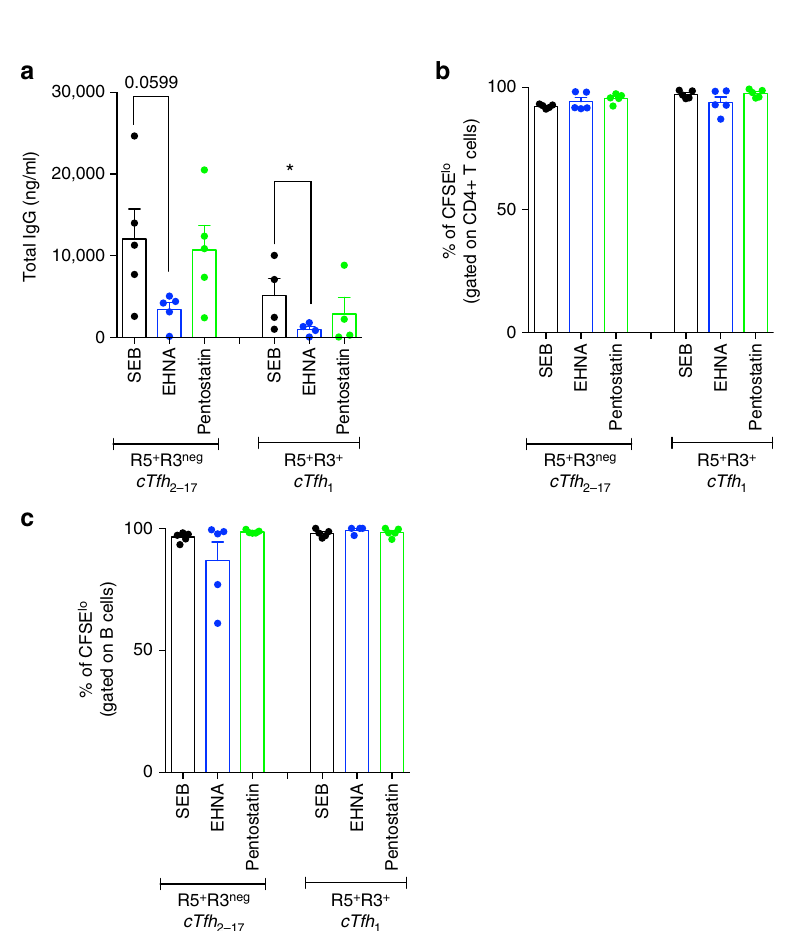
Fig. 3 Blocking of ADA with EHNA does not impair T- and B-cell proliferation abilities. a Production of IgG in the supernatants of 7-day co-cultures of cTfh and non-cTfh co-in the presence of ADA-inhibitors EHNA or Pentostatin ( n = 5, in two-independent experiments). (ANOVA, paired, two-tailed non- parametric t -test; * p < 0.05; Mean ± SEM). b Percentage of CFSE lo T cells after 7-day co-cultures of cTfh subsets with memory B cells in the presence of ADA-inhibitors EHNA or Pentostatin ( n = 5 per group, in two-independent experiments; Mean ± SEM). c Percentage of CFSE lo B cells after 7-day co- cultures with cTfh subsets in the presence of ADA-inhibitors EHNA or Pentostatin ( n = 5 per group, in two-independent experiments; Mean ± After 7 days of co-culture (after activation), only A1R level was upregulated on cTfh, non-cTfh (Supplementary Fig. 11A – D) and B-cells subsets (Supplementary Fig. 11E). Interestingly, addition of exogenous ADA-1 or ADA-1 inhibition did not affect ARs expression by either cTfh subsets (Supplementary Fig. 12C,D) or memory B cells (Supplementary Fig. 12E,F). stimulating A2aR and A2bR signaling with agonists (i.e., induce